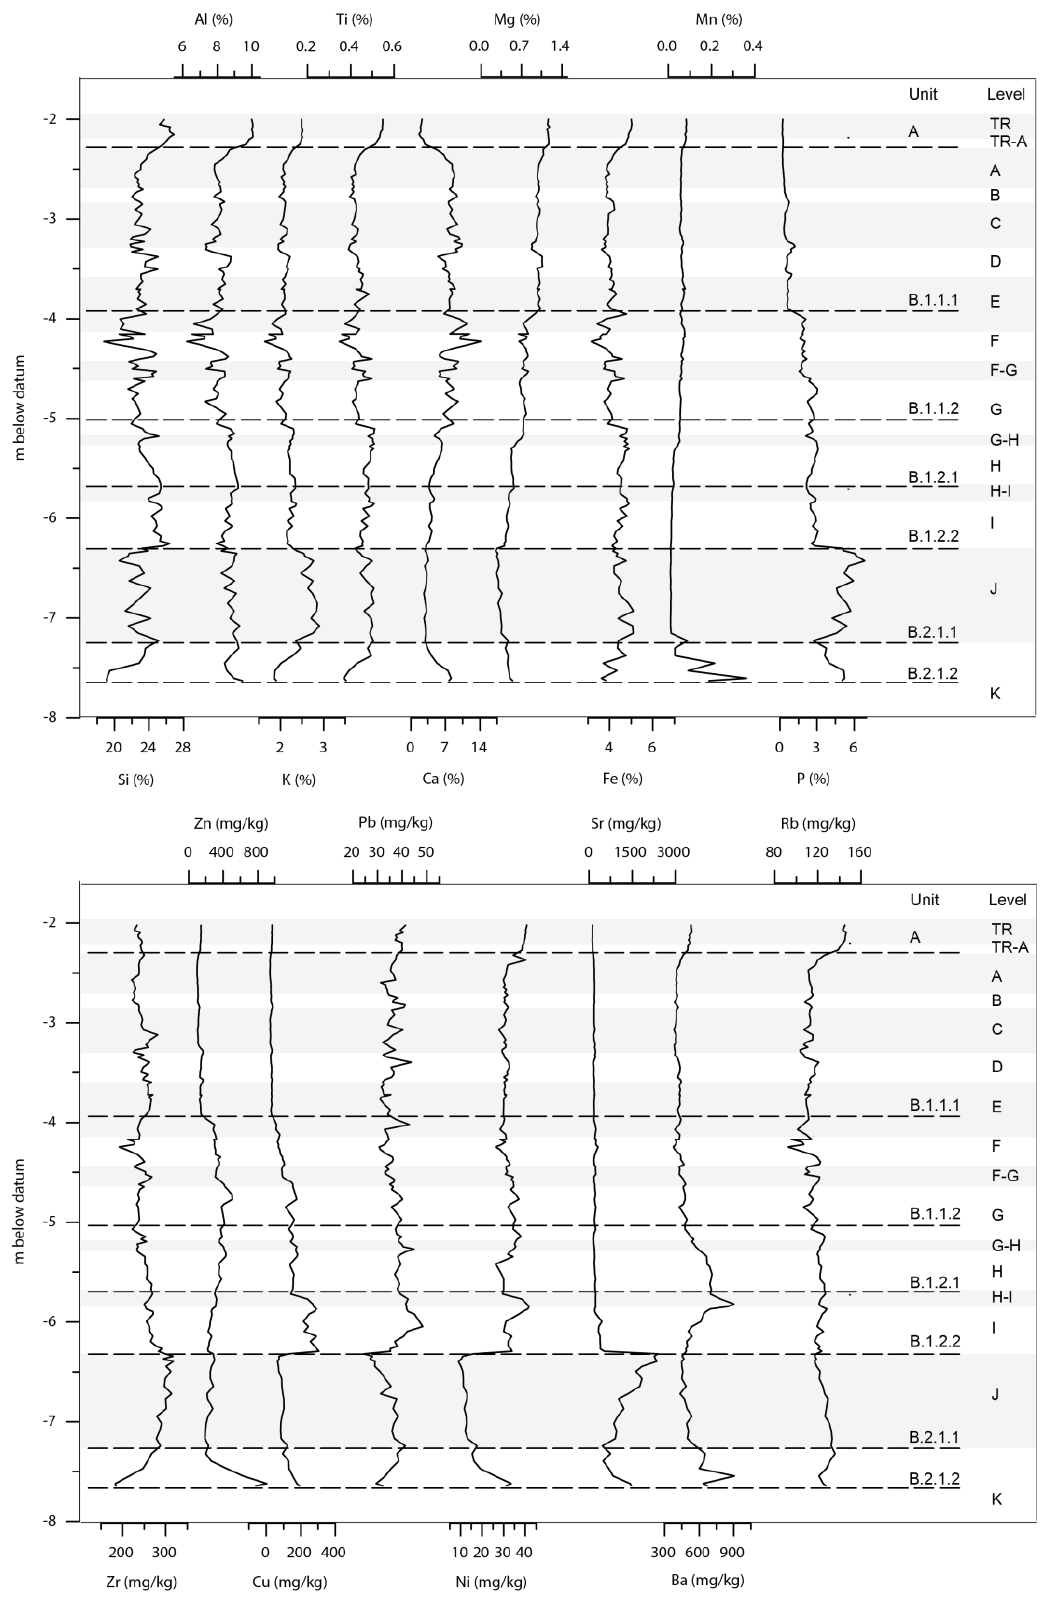
Figure 7. Major and trace elements in the fine fraction ( < 2mm in diameter) of the north profile at square E 0 at Arbreda. Figure 7: Major and trace elements in the fine fraction (< 2 mm in diameter) of the north 2 Clim. Past, 10, 1673–1692, profile at square E0 at Arbreda. 3